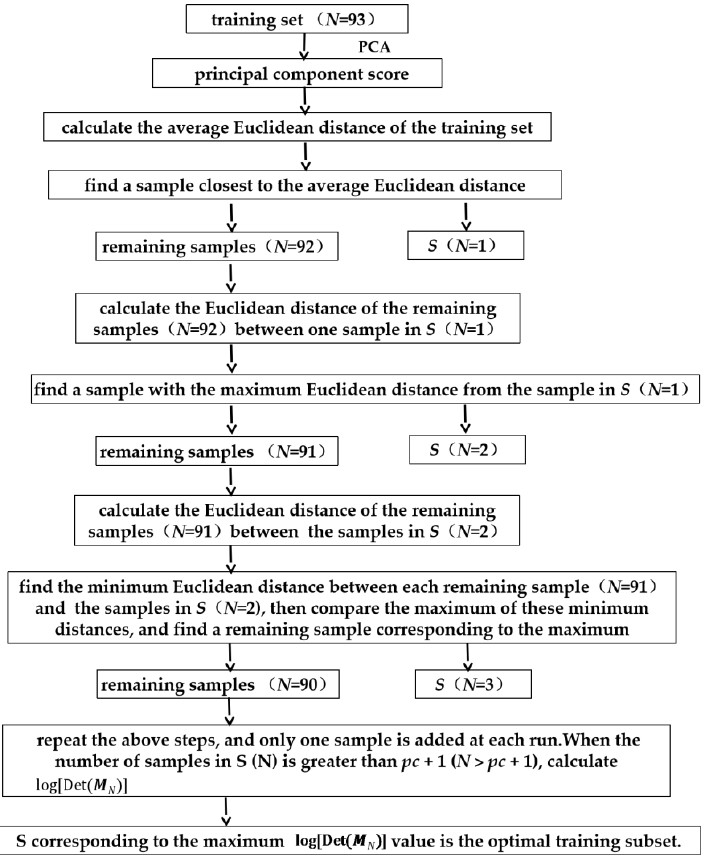
Figure 1. The steps of the AKS algorithm.